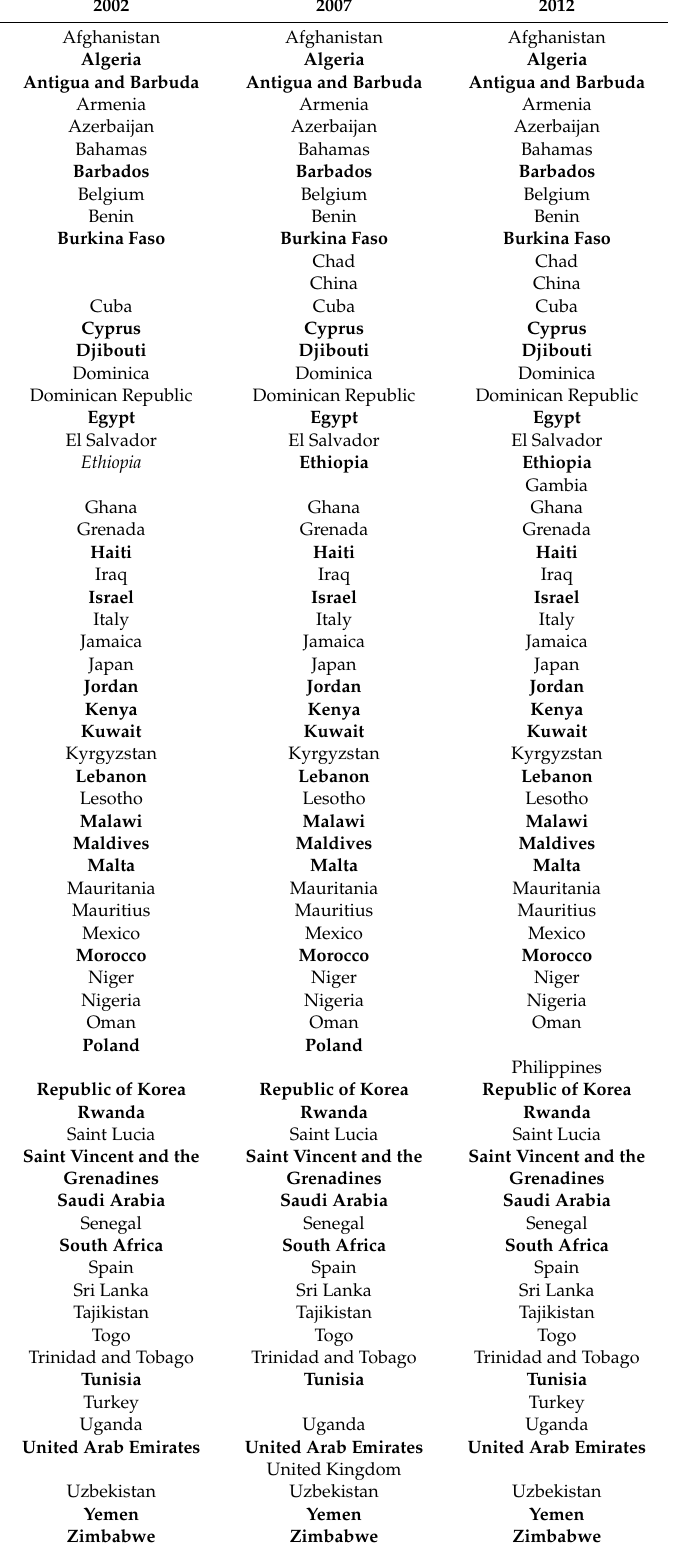
* Countries below or equal to the threshold of 1588 m 3 per capita are highlighted in